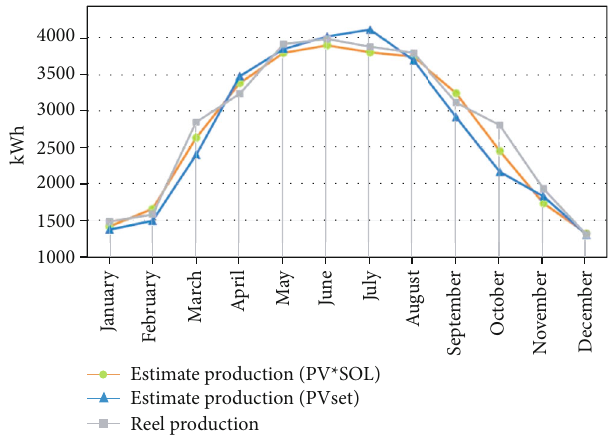
Figure 2: Estimated graph of energy injected into grid.